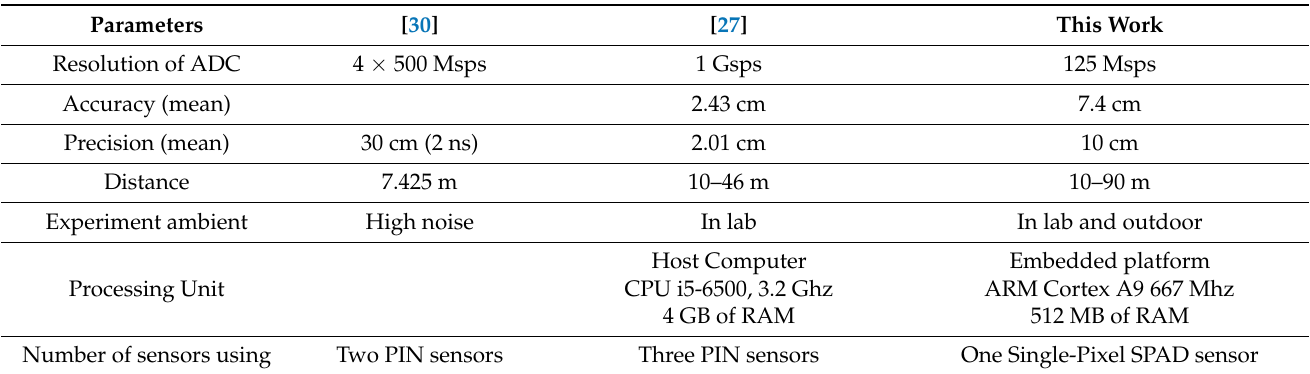
Table 1. Comparison of this work with recent